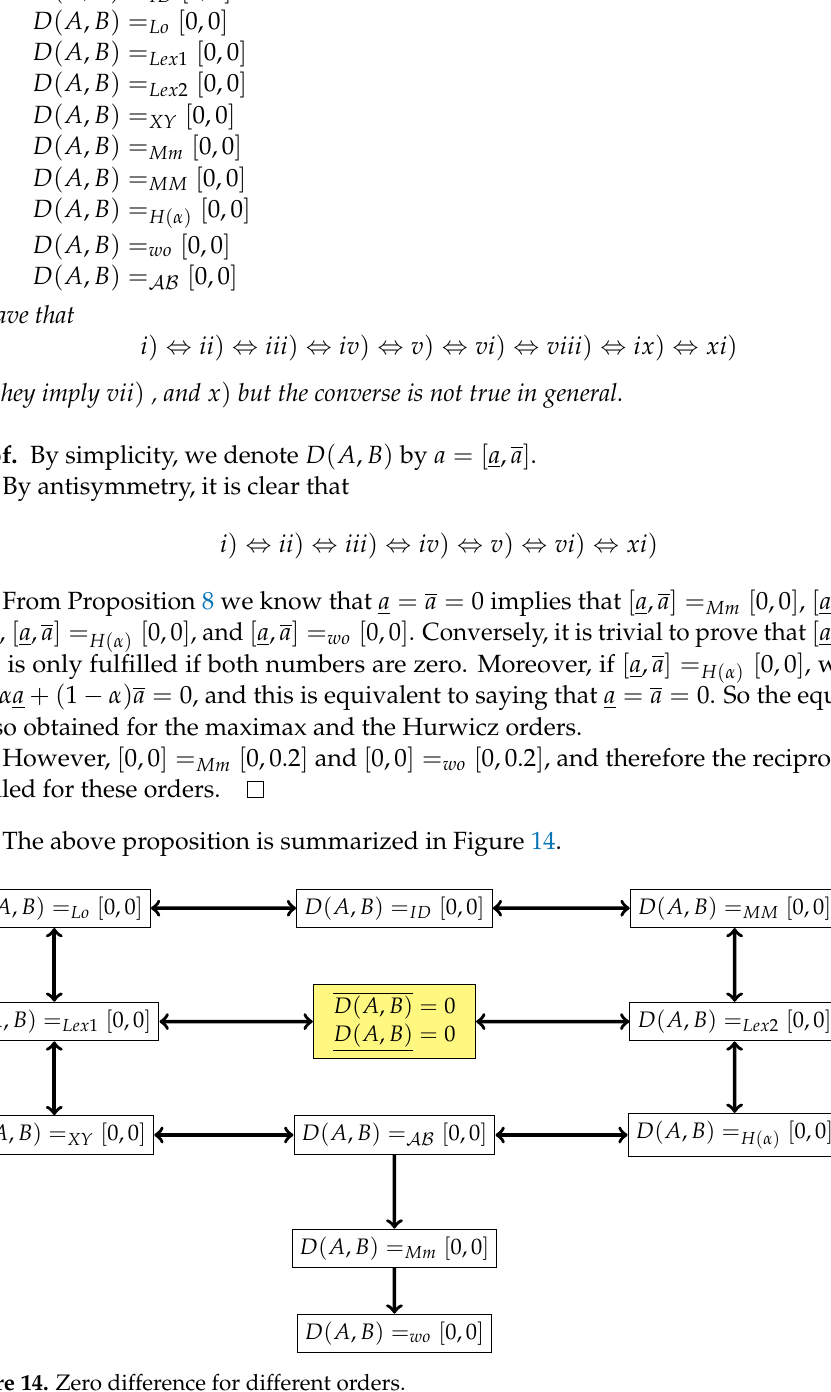
Figure 14. Zero difference for different